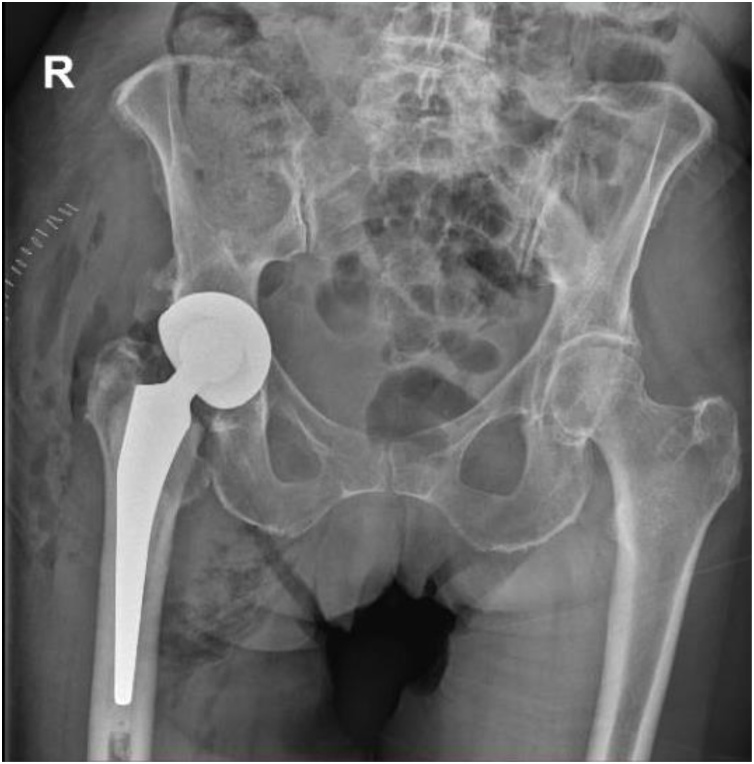
Plain X-ray after revision of the total hip arthroplasty with dual mobility cup and cemented stem.